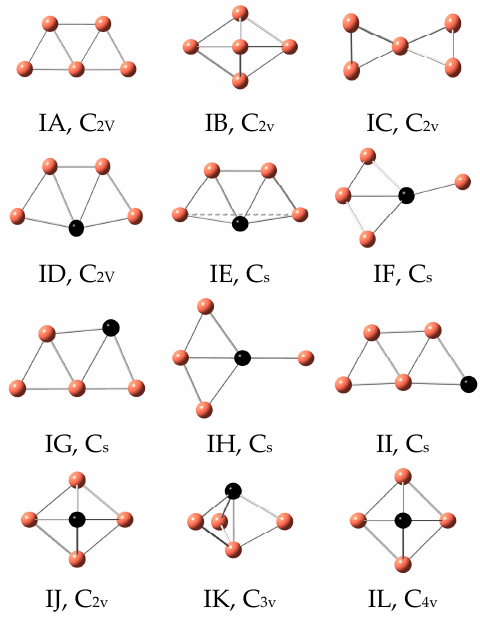
Figure 1. The ground state and low-lying isomers of Cu 4 M (M = Sc-Cu) clusters. Table 2. The lower energy isomer (LI), Δ E and spin multiplicity (SM) of Cu 5 and Cu 4 M (M = Sc-Ni) clusters at the B3LYP/LanL2DZ and Blyp/6-311+G(d) levels.